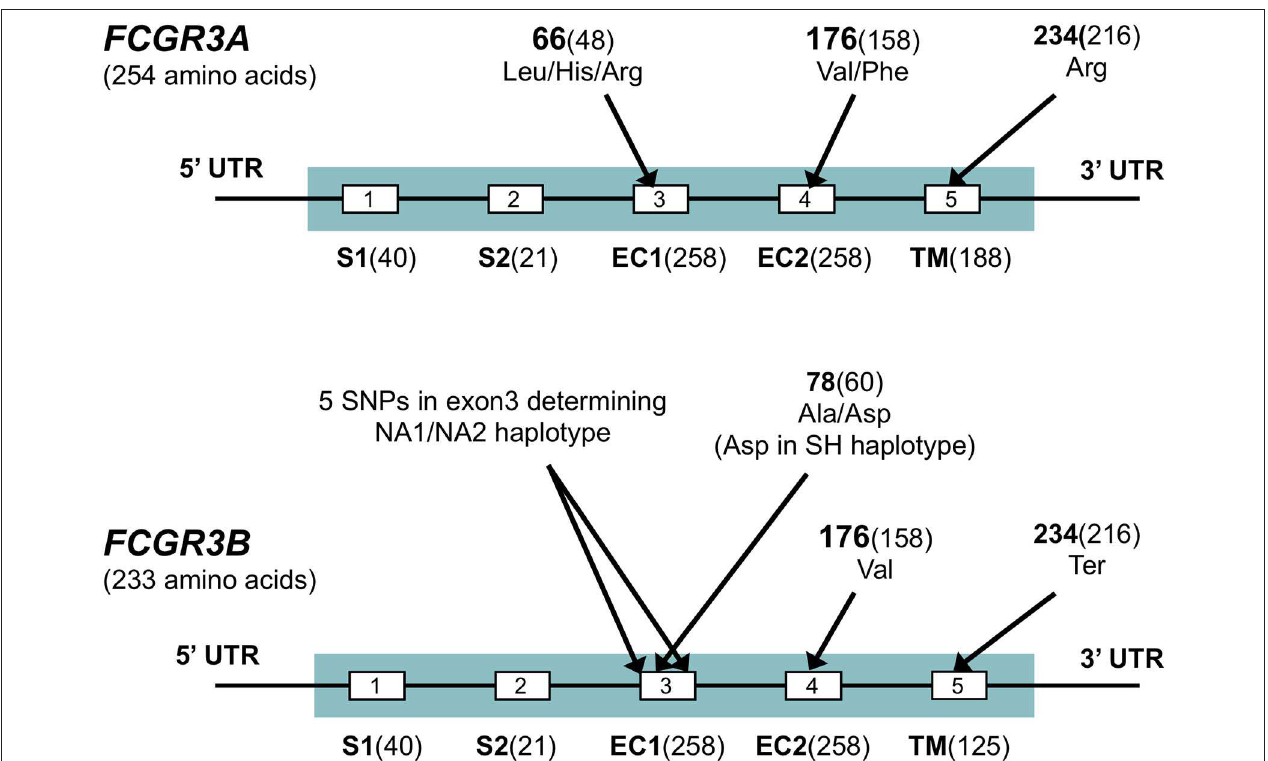
FIGURE 4 | FCGR3 exons. Exons are shown by boxes. Exon names are below and followed by the number of coding base pairs in that exon. S1, S2, signal peptides; EC1, EC2, extracellular domains; TM: transmembrane domain. Several SNPs are indicated in the figure, all are indicated by their amino-acid position in the full protein, followed by the amino acid position excluding signal peptides between brackets for some of the SNP which are commonly known by that position. Sequences for FCGR3A and FCGR3B are very similar, but four non-synonymous differences in the coding sequence exist, most notably the stop codon at p.234 in FCGR3B as indicated in the figure, which truncates the transmembrane domain of this receptor. Other amino acid differences between FCGR3A and FCGR3B include p.147 (Gly in FCGR3A , Asp in FCGR3B ), p.158 (Tyr in FCGR3A , His in FCGR3B ) and p.203 (Phe in FCGR3A , Ser in FCGR3B ) (41). A set of 6 SNPs in exon3 of FCGR3B form three rather well-defined haplotypes, the FCGR3B -NA1, -NA2 and -SH. FCGR3A is identical to NA1 at some sites, but to NA2 at others